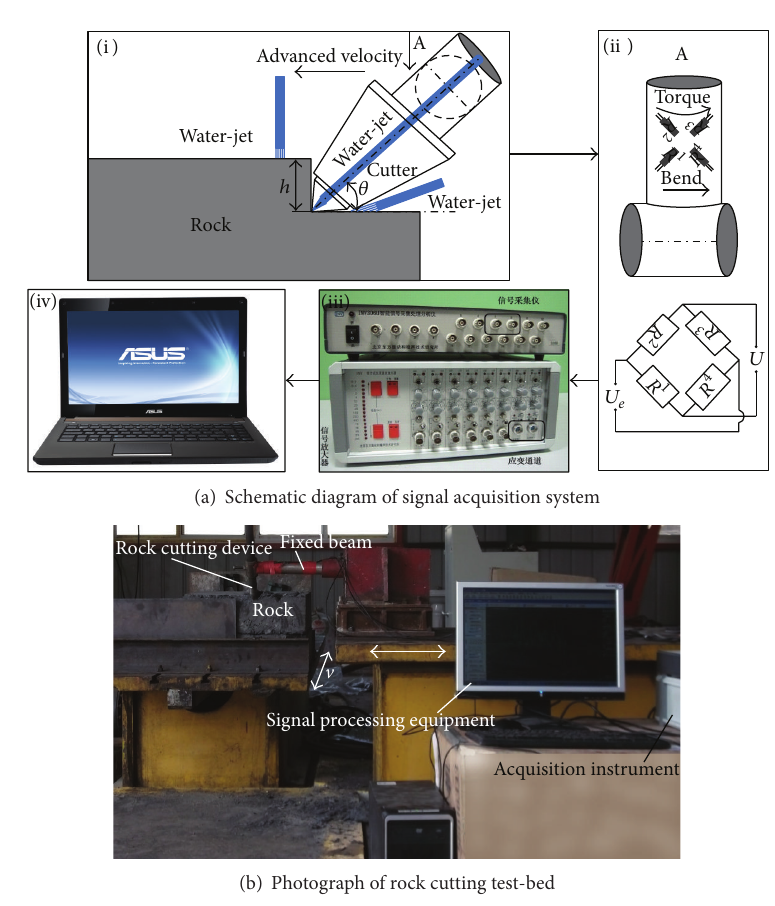
Figure 2: Rock cutting test-bed.